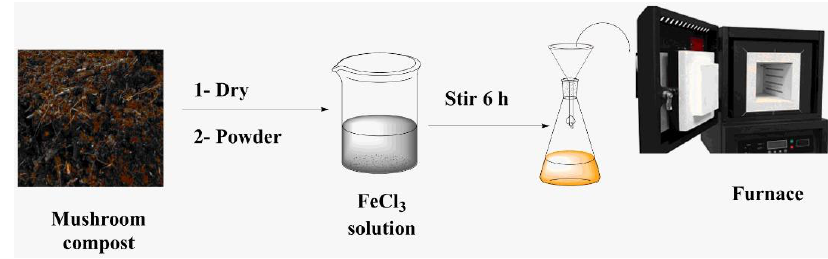
Figure 1. Modification process of